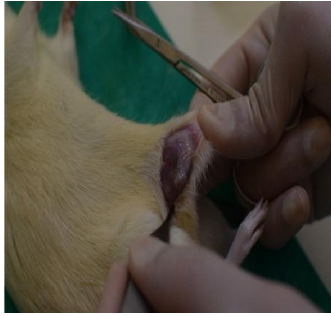
Figure 1. Silicon implant non treated – moment of extraction of the implant with the view of the remaining thick capsule.